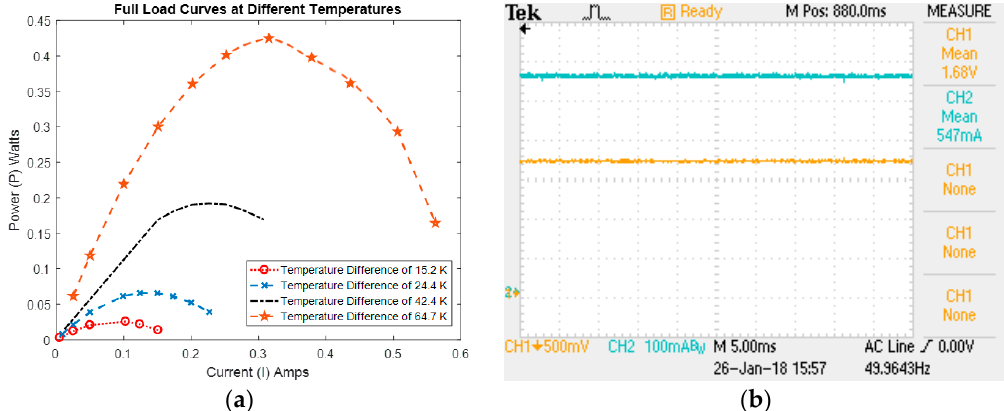
Figure 13. ( a ) Effect of full load tests at four different ∆ T on the output load power ( P L ) connected to the variable load resistor ( R L ) equivalent to R i , and ( b ) oscilloscope DC V L and I L , which is approximately half of the V oc and I sc showing the maximum power point.